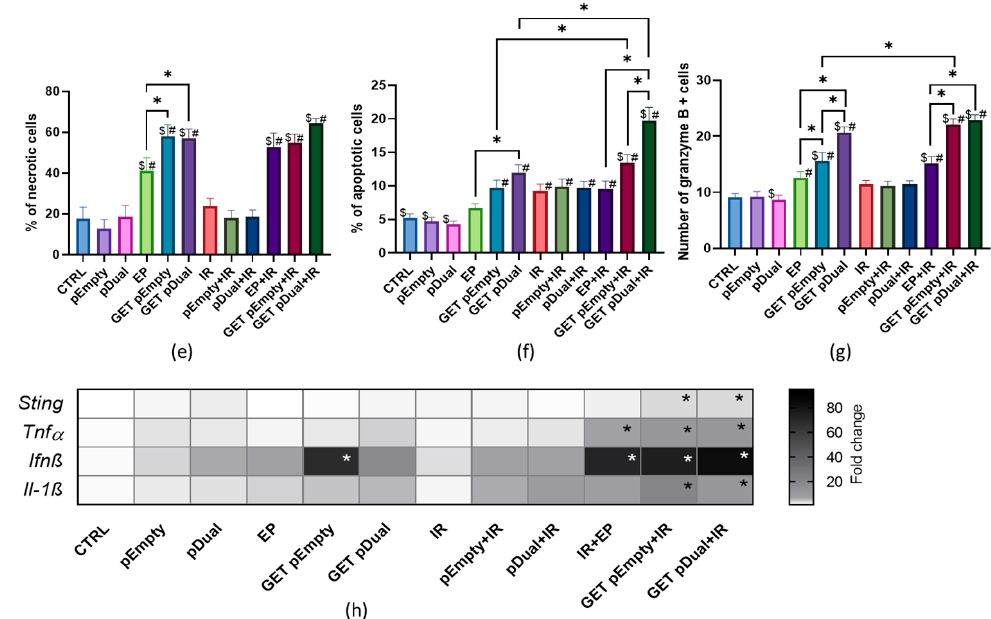
Figure 2. Histological analysis and expression of inflammatory cytokines and Sting. ( a ) Histological tumor sections on day 6 after the beginning of the therapy: vascularization, CD31 staining; proliferation, Ki-67 staining; hypoxia, hypoxia inducible factor-1- α staining; necrosis, HE staining; apoptosis, cleaved Caspase-3 staining; and immune infiltration, granzyme B staining. Scale bar in tumor section, 50 µ m; scale bar in whole tumor area (necrosis), 500 µ m. ( b ) Vascularization. ( c ) Proliferation. ( d ) Hypoxia. ( e ) Necrosis. ( f ) Apoptosis. ( g ) Immune infiltration. The data represent the arithmetic mean with the standard error of the mean per field of view; n = 6 tumors per group, of which at least 5 viable parts of the tumor were analyzed. #, p < 0.05 vs. CTRL; $, p < 0.05 vs. IR; *, p < 0.05 vs. indicated group (only relevant comparisons are displayed: EP vs. GET pEmpty, EP vs. GET pDual, GET pEmpty vs. GET pDual, EP + IR vs. GET pEmpty + IR, EP + IR vs. GET pDual + IR, and GET pEmpty + IR vs. GET pDual + IR). ( h ) Expression of cytokines Il1 β , Ifn- β 1 and Tnf- α and DNA sensor Sting on day 6 after the beginning of the therapy. *, p < 0.05 vs. CTRL. CTRL, control; GET, gene electrotransfer; IR